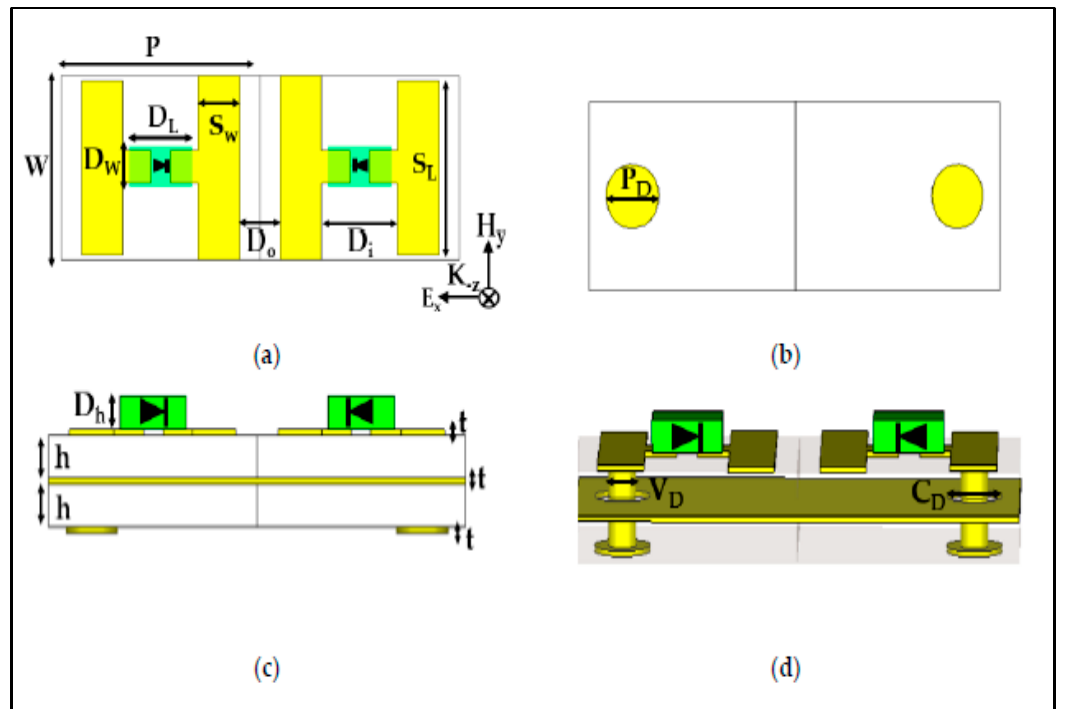
Figure 1. The design of two adjacent unit cells. ( a ) Unit cell top layer. ( b ) Unit cell back layer. ( c ) Side view of the unit cell. ( d ) 3D view of the unit cell [8].